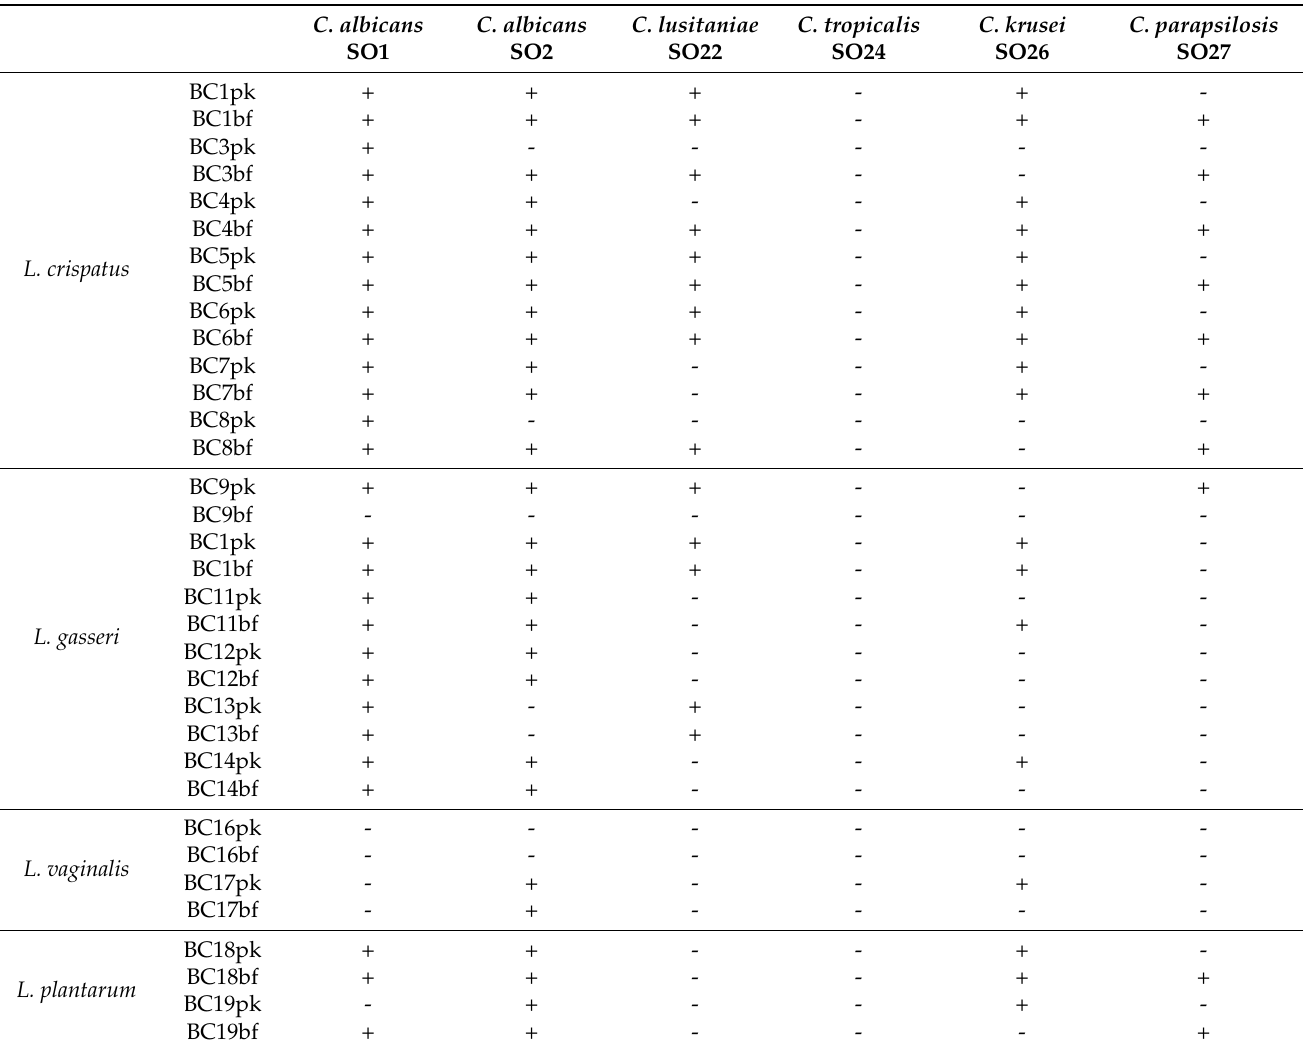
Table 1. Inhibition of Candida morphology switching by lactobacilli pk-CFS and bf-CFS. +, inhibition of germ tube, pseudohyphae, or hyphae formation, evaluated by microscopic observation of at least three microscopic fields; -, absence of inhibition (i.e., formation of germ tubes, pseudohyphae, or hyphae comparable to the corresponding control